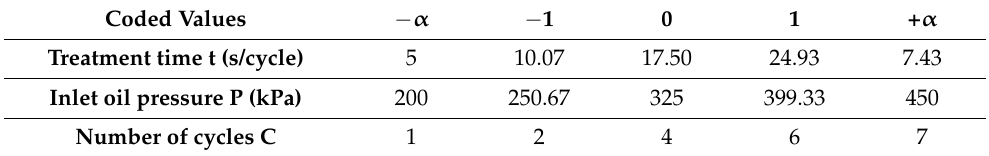
Table 1. MFA treatment parameters for the deodorization of crude palm oil. Coded Values − α − 1 + α Treatment time t